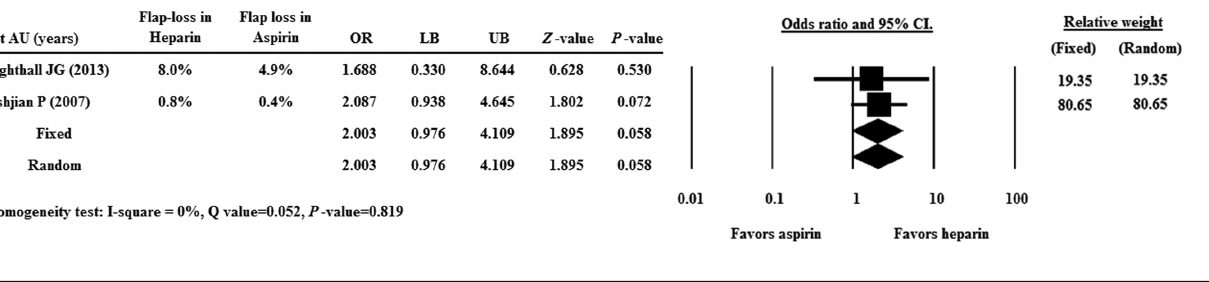
Figure 2. Forest plot showing odds ratios (ORs) of flap lossbetween heparin and aspirin. Data are presented as OR with the 95% confidence interval (CI). A value of p , 0.05 indicates a statistically significant difference.